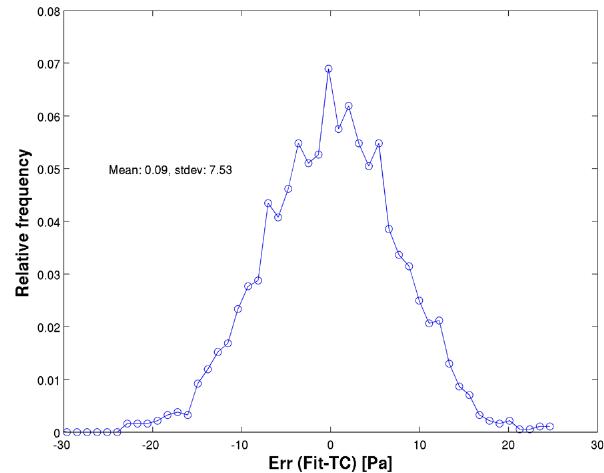
Fig. 5. Distribution of residual error (DP algorithm prediction minus TC measurement) [ Pa ] (10Hz